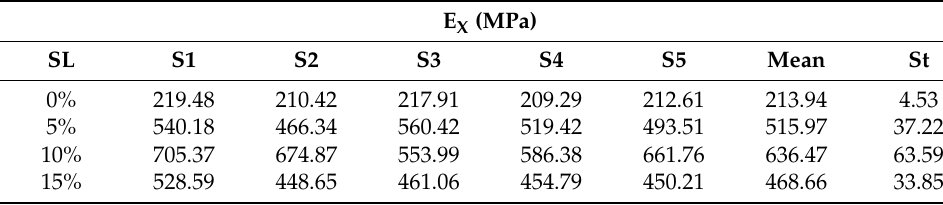
Table 3. Secant modulus (MPa) for X samples.